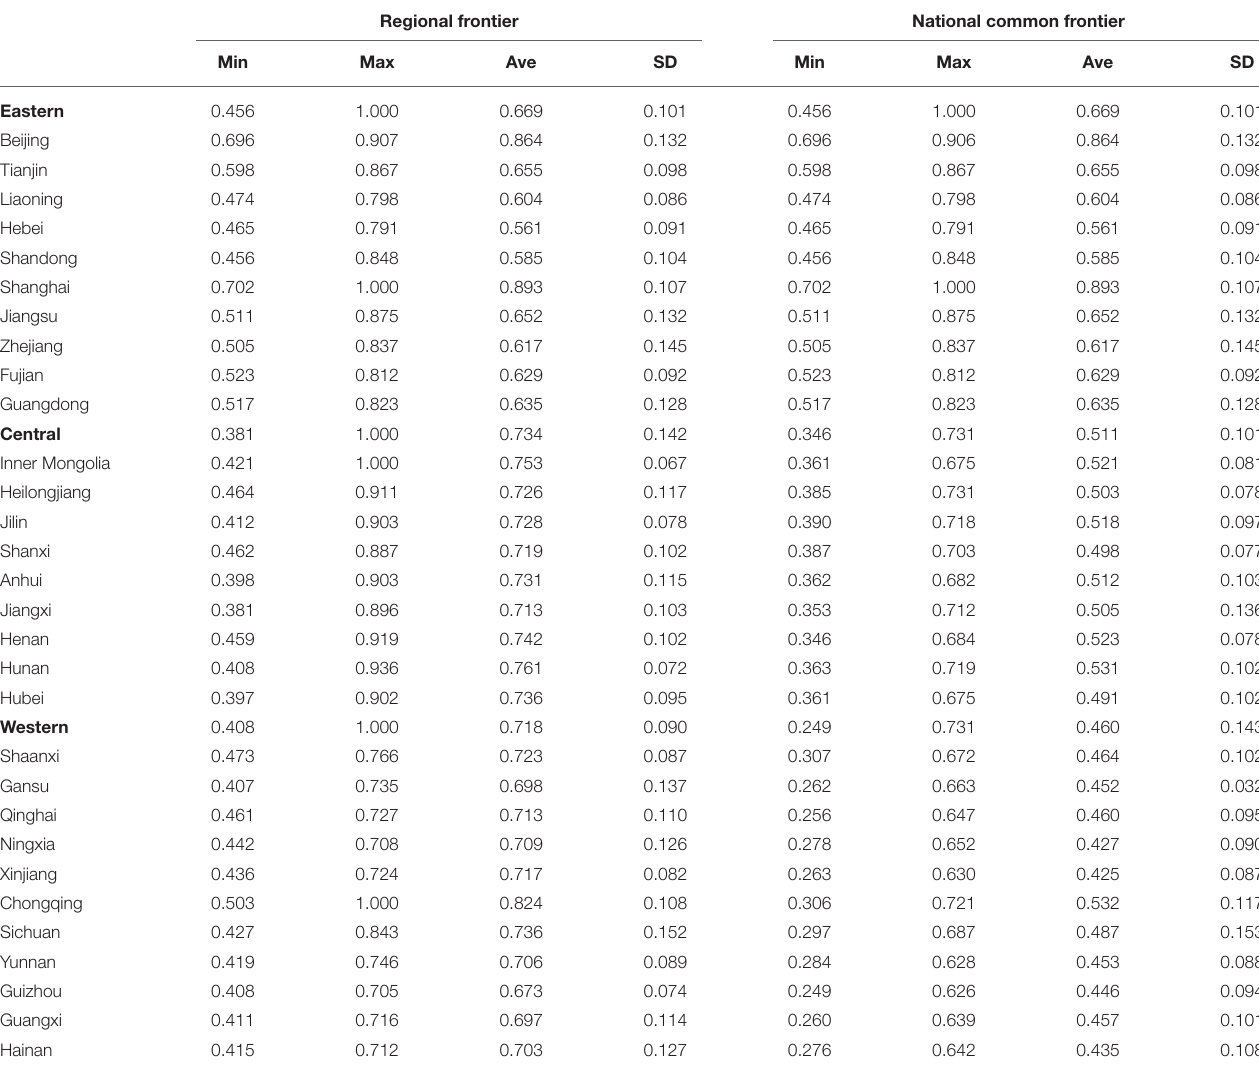
TABLE 3 | Health expenditure efficiency under the regional and national common frontiers. Regional